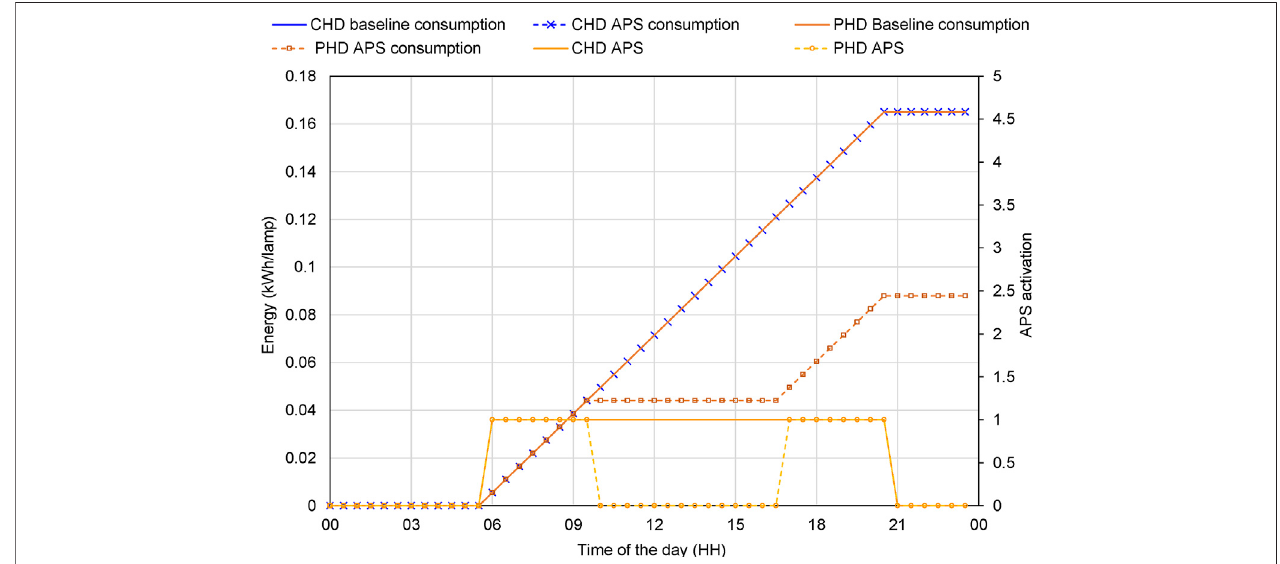
FIGURE 7 | Daily cumulative lighting energy pro fi le.